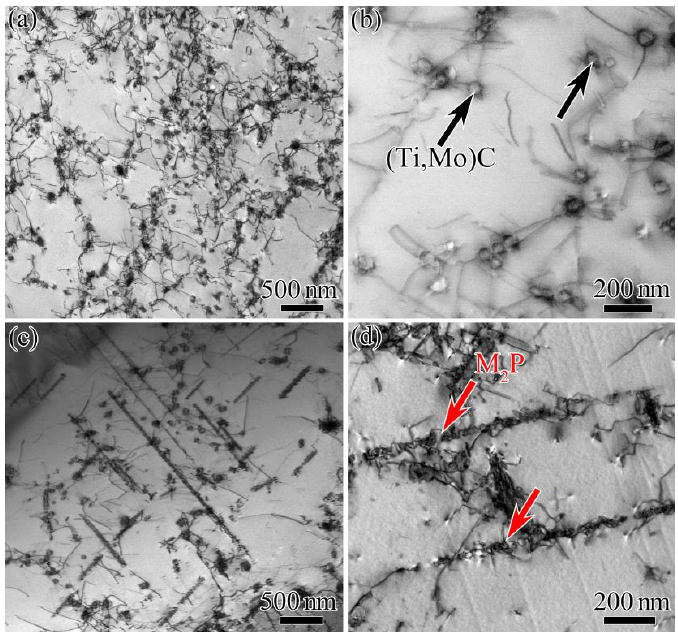
Figure 6. The TEM images of the 15Cr–15Ni–Ti–xP alloy after aging at 850 °C for 1000 h: ( a , b ) 15Cr–